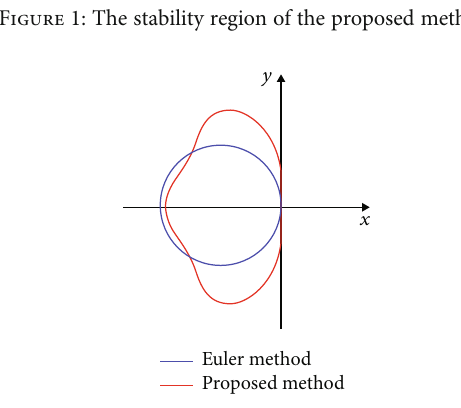
Figure 2: The stability regions of Euler and the proposed